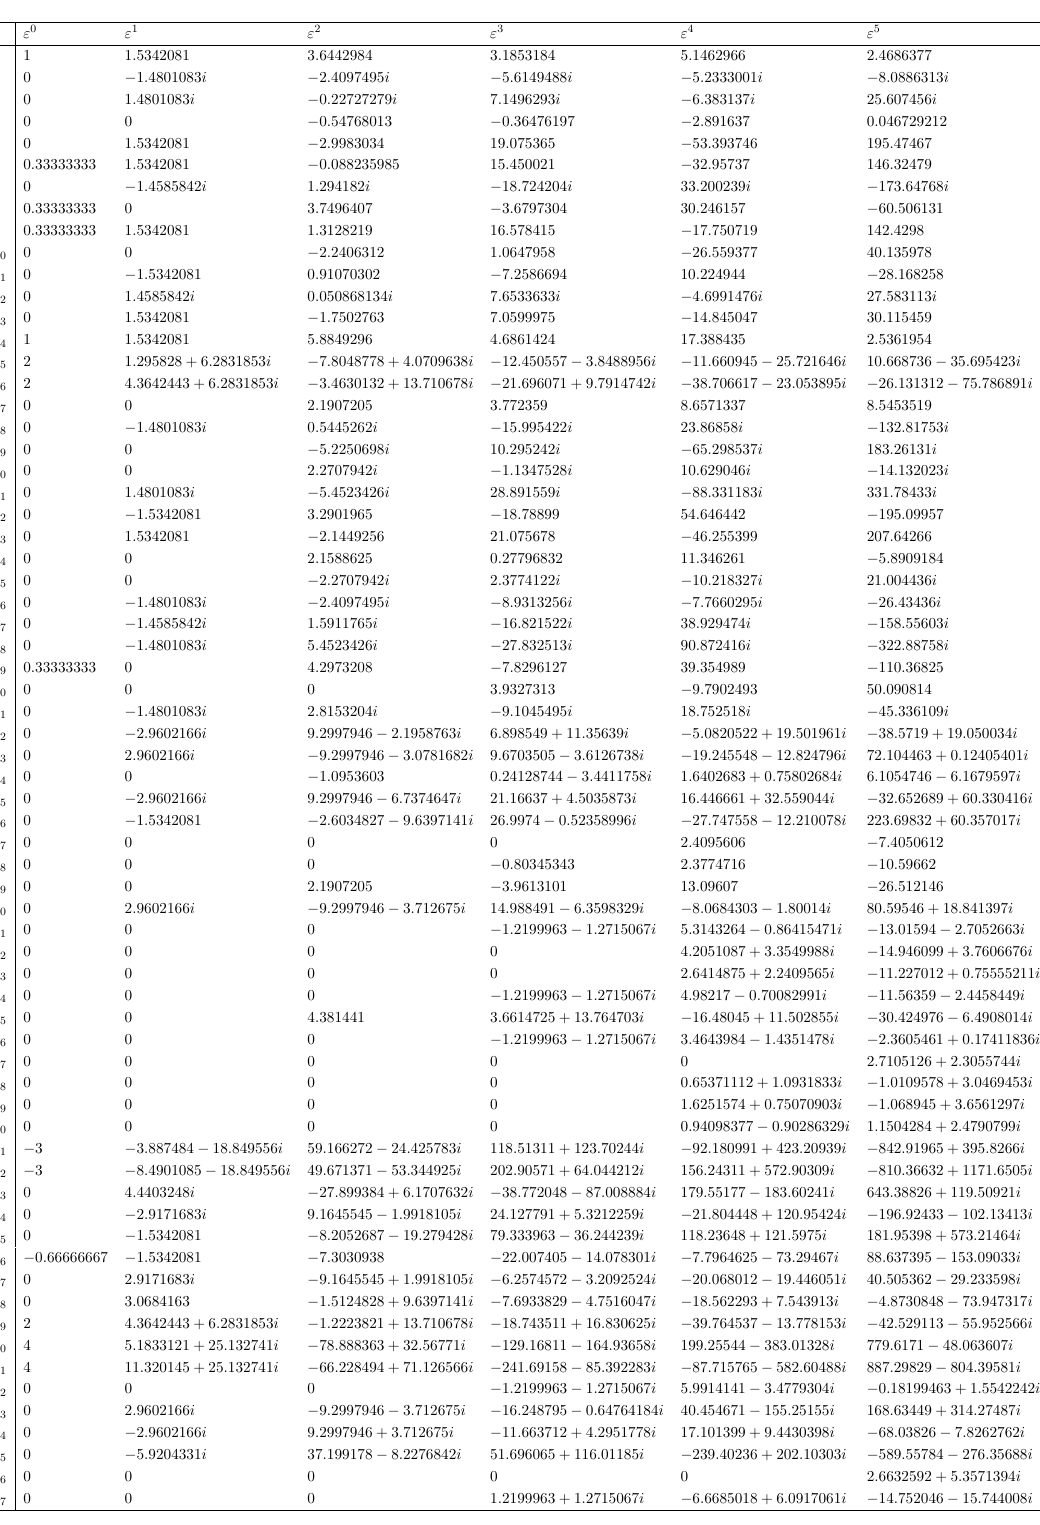
Table 5 . Numerical results for the first six terms of the ε -expansion of the master integrals J 1 - J 67 at the kinematic point p 2 = m 2 H